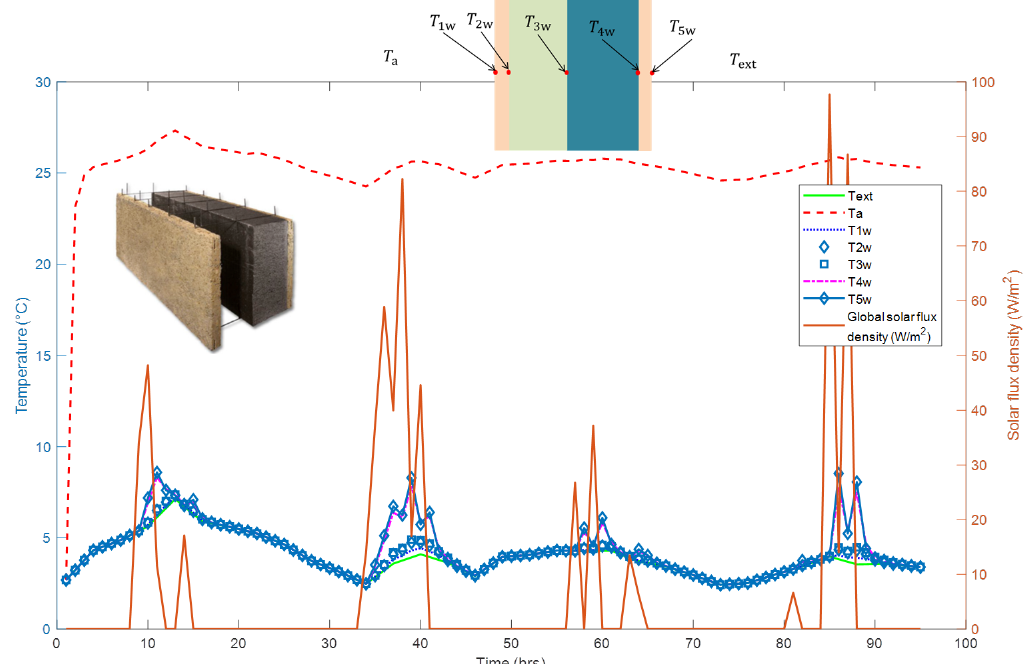
Figure 10. Global solar radiation with ambient and wall layers temperature dynamics profile.